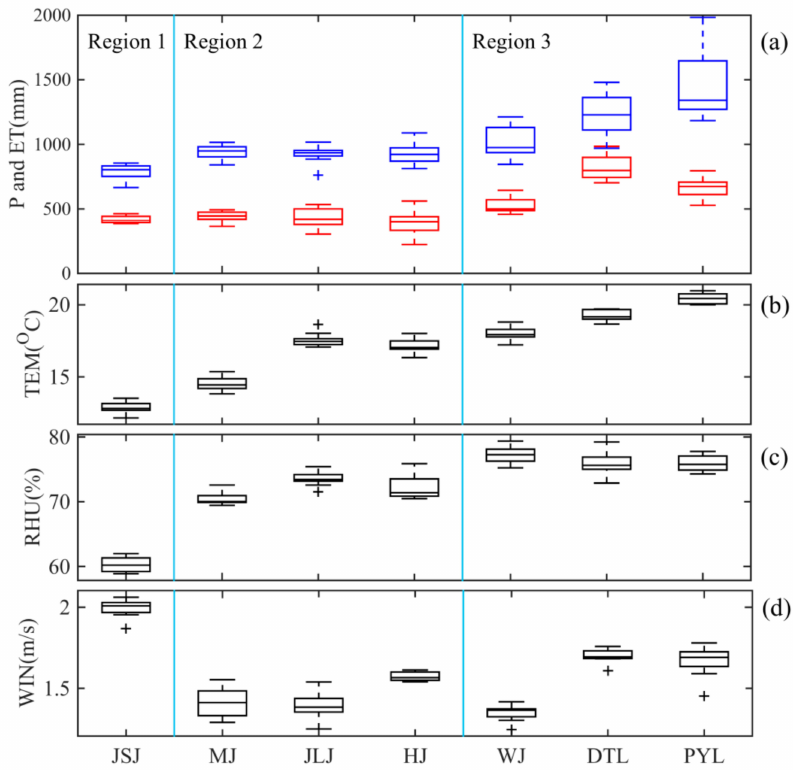
Figure 8. Limitation factors of ET in the seven subcatchments, i.e., TEM, RHU, and WIN. And the name for each subcatchment are Jinshajiang (JSJ), Minjiang(MJ), Jialinjiang (JLJ), Hanjiang (HJ), Wujiang (WJ), Dongting Lake (DTL), and Poyang Lake (PYL). For each box, the central mark is the median, edges represent the 25th and 75th percentiles, and whiskers extend to the furthest data points not considered outliers (outliers are plotted individually). ( a ) Blue boxes denote precipitation ( P ) for each region, and red boxes denote ET for each subcatchment; Boxes in ( b – d ) denote temperature (TEM), relative humidity (RHU), and wind speed (WIN) for each subcatchment,